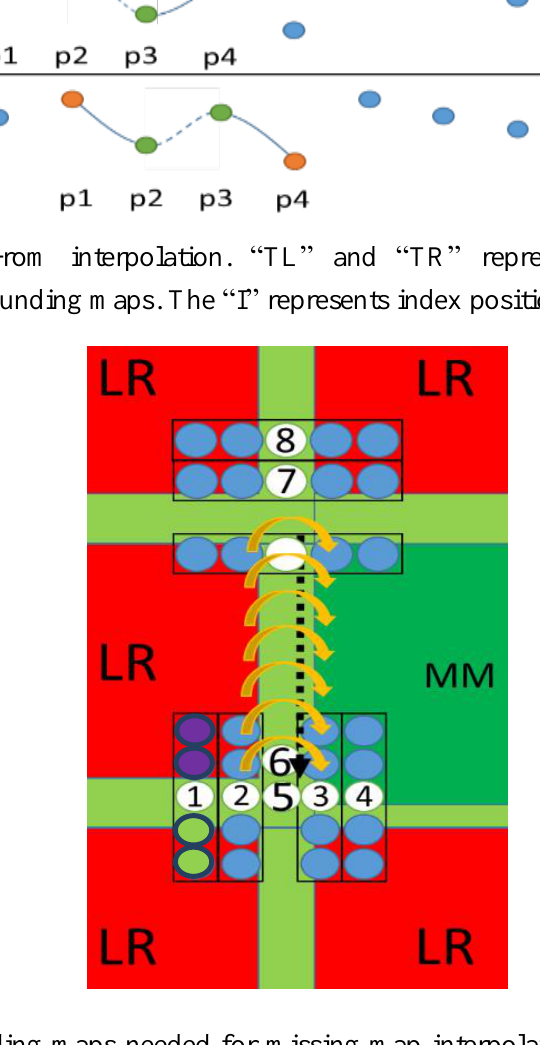
Figure 10. Surrounding maps needed for missing map interpolation for higher resolution maps. Left tangent line